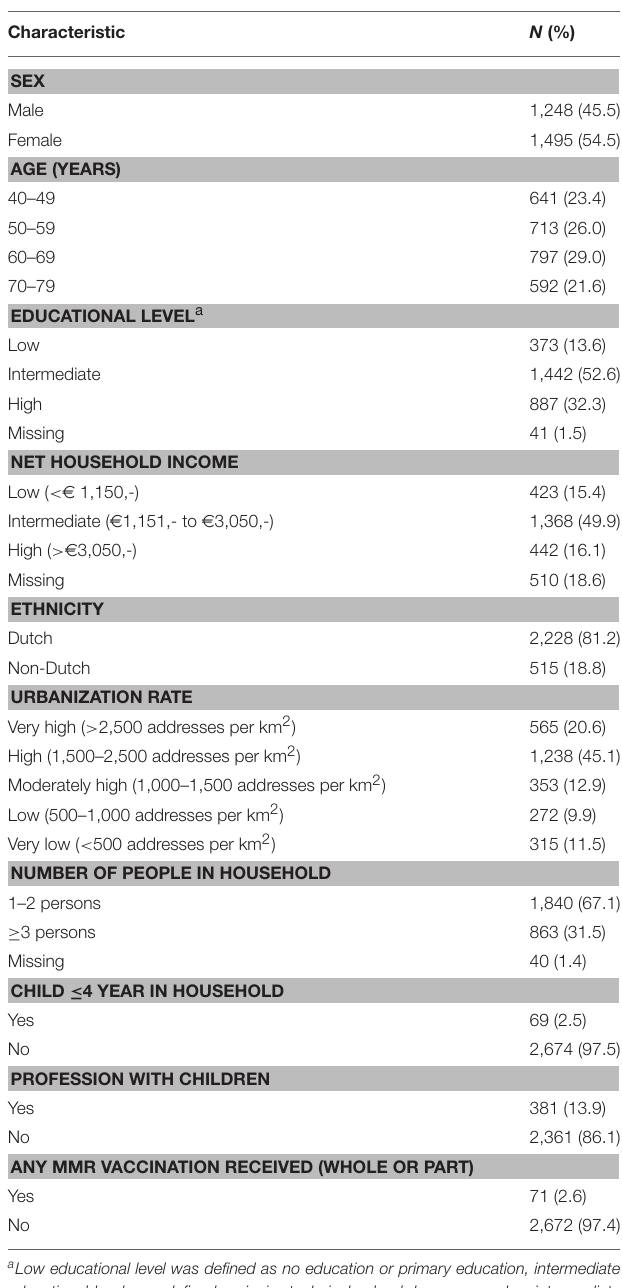
TABLE 1 | Descriptive characteristics of participants from the Pienter2 national sample 40–79 years, with blood sample and questionnaire available ( N = 2,743).